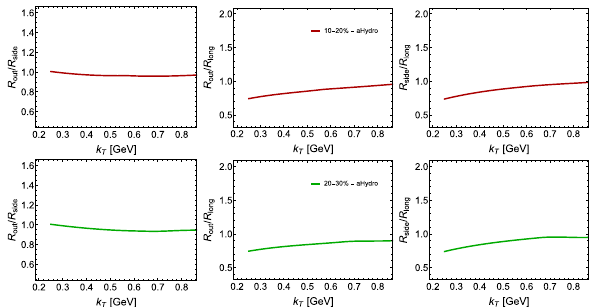
Fig. 10 Ratios of HBT radii as a function of k T for π + π + in the 10– 20, and 20–30% centrality classes. The left, middle, and right columns show R out / R side , R out / R long , and R side / R long , respectively. All results are for 5.023 TeV Pb–Pb